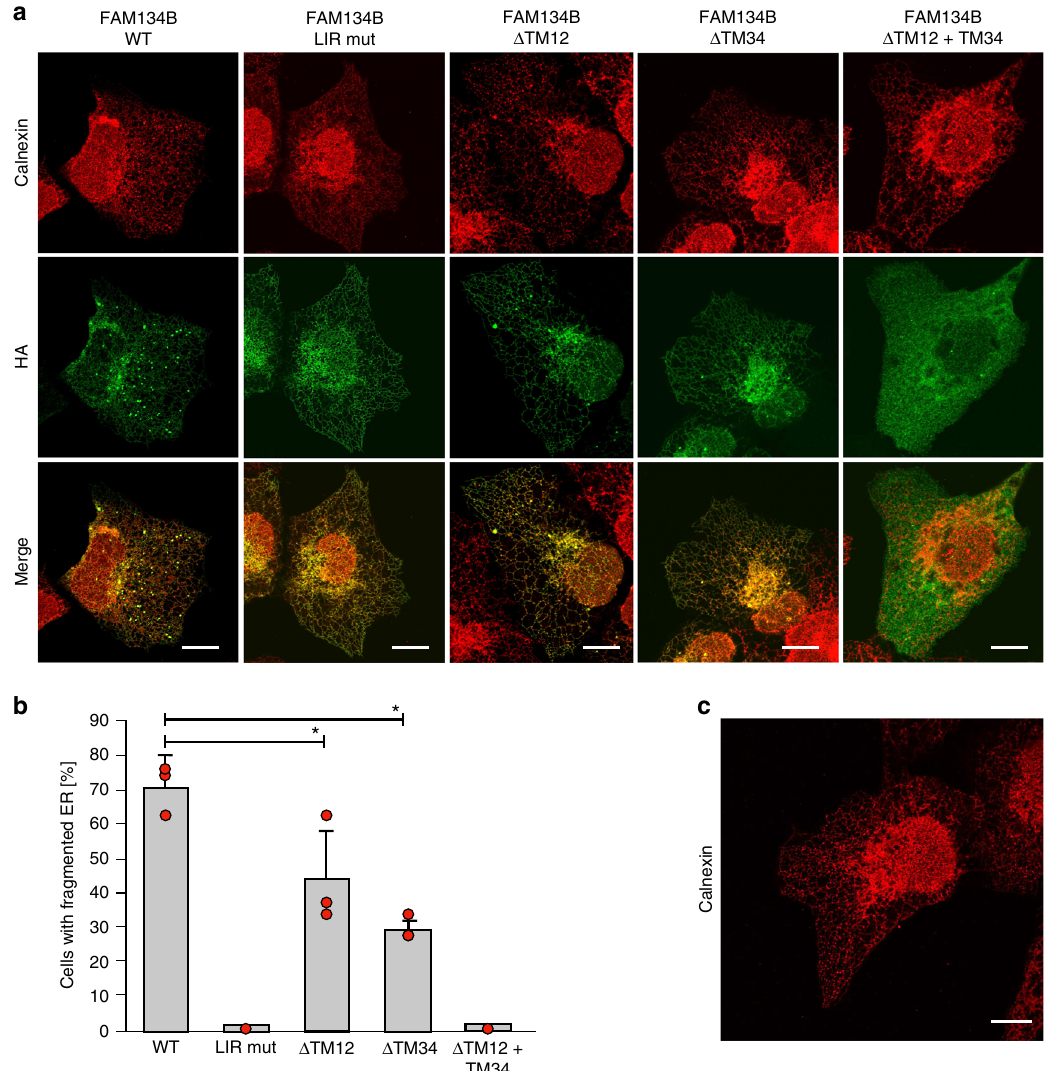
Fig. 7 TM hairpins of FAM134B are required for ER fragmentation. a Immuno fl uorescence of HA and endogenous calnexin in U2OS cells transiently overexpressing HA-tagged FAM134B (left to right): wild-type (WT), LIR mutant (LIR mut), single hairpin deletions ( Δ TM12 and Δ TM34), and the double hairpin deletion ( Δ TM12 + TM34). Scale bars 10 μ m. b Quanti fi cation of U2OS cells with fragmented ER ( ≥ 5 ER fragments per cell) after transient over- expression of wild-type and mutant forms of FAM134B. Error bars indicate s.d. from triplicates (red fi lled circles) and *Denotes p < 0.05 in two-sample Student ’ s t -tests. c Immuno fl uorescence of endogenous calnexin in un-transfected U2OS cells. Scale bar 10 μ